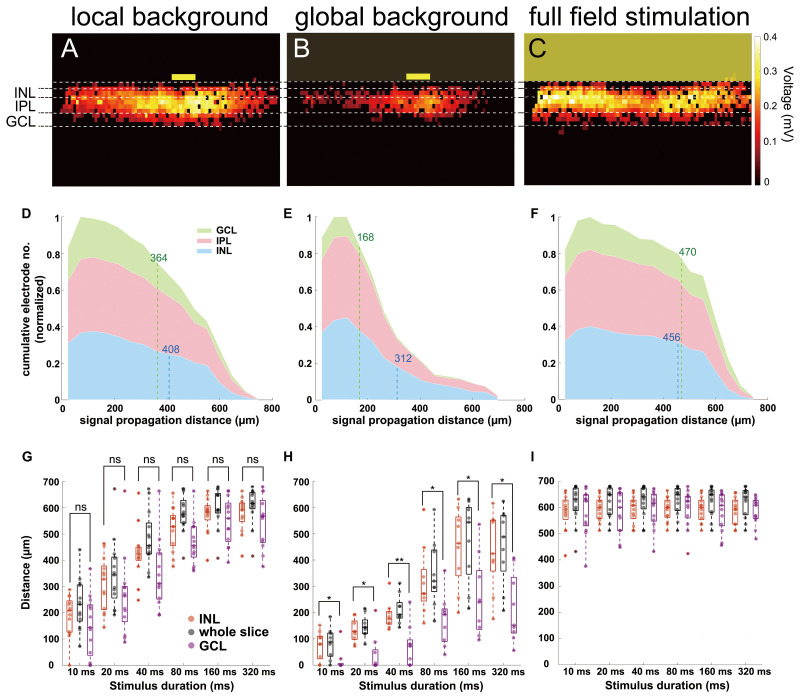
Signal propagation in the inner nuclear layer (INL) and ganglion cell layer (GCL) in three light stimulus conditions. (A–C) Heat maps showing active electrodes from 160 ms light-induced field potential. The position of different retinal layers is marked. The heat map color codes for the maximum extracellular voltage. (A) Local background stimulation. (B) Global background stimulation. (C) Full-field stimulation. The yellow boxes mark the stimulus position and size [100-μm wide in (A,B)]. (D–F) Cumulative distribution diagrams from three different stimuli. The diagrams present the normalized active electrode number to distance from the stimulus in different retinal layers under 160 ms light stimulus. (D) Local background stimulus. (E) Global background stimulus. (F) Full-field stimulus. Numbers labeled at the INL (blue dashed lines) and at the GCL (green dashed lines) mark the 80% limit in the distribution as a benchmark distance to avoid the misjudgment of the propagation by outlier electrodes. (G) Box plot of signal propagation distance under local background stimulus measured in whole slice (black), INL (red), and GCL (purple). The signal propagation distances in INL and GCL show no significant difference in any of the stimulus duration. Each symbol represents the result from one slice under the specified condition. (H) Same as (G) for global background stimulus. The signal propagation distances are significantly larger in INL than in GCL. (I) Same as (G) for full-field stimulus; the signal propagation distances are similar regardless of measuring the whole slice, INL, or GCL. Significance tests were performed with the Wilcoxon rank-sum test. *P < 0.05 and **P < 0.01.